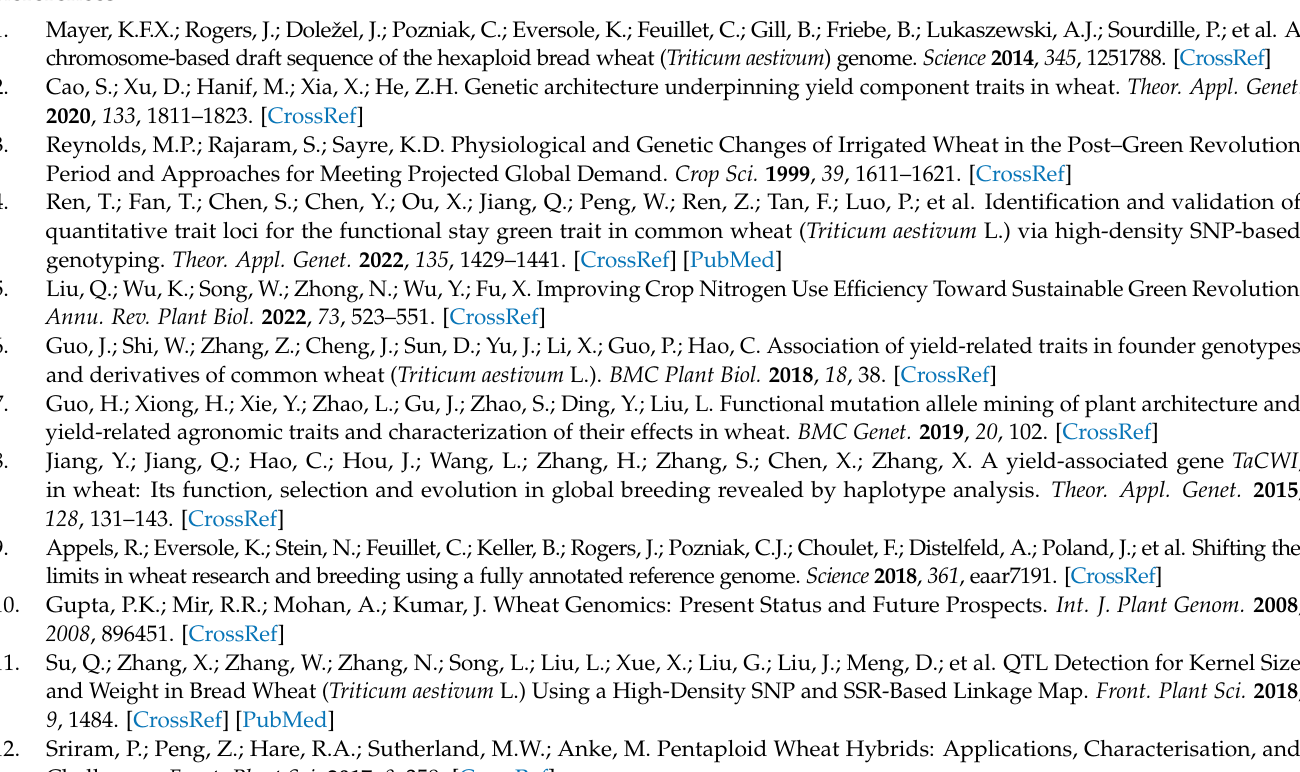
QSB.nwafu-2B.2 on kernel number per spike (KPS) ( a ) and thousand-kernel weight (TKW) ( b ); Figure S4: Interaction of QAC.nwafu-3A.1 and QAC.nwafu-4A.1 on awn color (AC); Table S1: Dis- tribution of markers on 14 chromosomes in the genetic map; Table S2: Distribution of segregation distorted markers and regions on chromosomes; Table S3: All of the QTLs in this study for